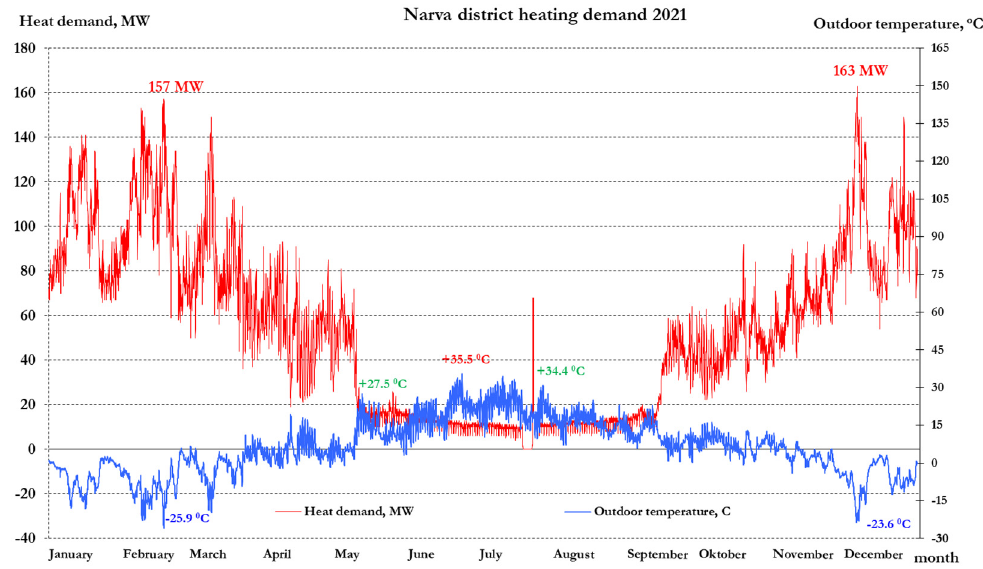
Figure 5. Actual heat demand for the Narva district heating system in 2021.